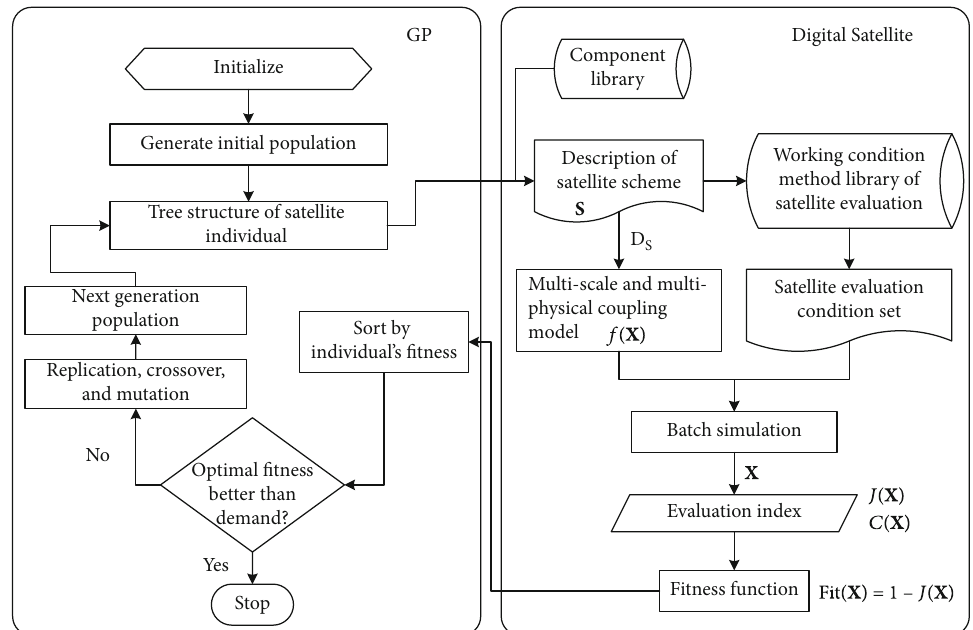
Figure 1: Flowchart of two-level optimization of satellite system topology and parameter. The component library consists of all component models that can support the satellite system design [14, 25]. Fit ð X Þ is the fi tness